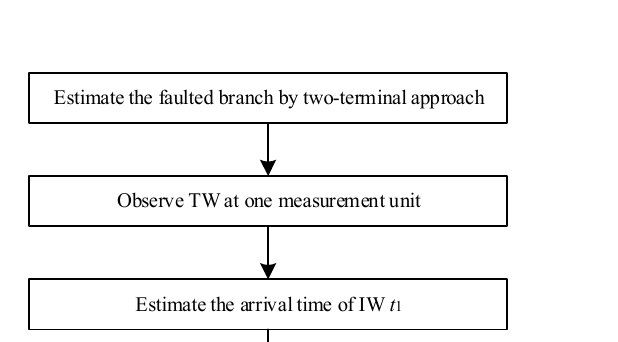
Figure 5. Wavelet-transform modulus-extremum (WTME) of the aerial-mode TW. 3.3. Consideration of Reducing Measurement Units in a Complex Network This section generalizes the two-step fault location approach in a complex network. As shown in Figure 6, a multi-level branch network is divided into two sub-networks to reduce the measurement units as much as possible. The basic idea is, in each sub-network, to select a backbone along which single-level branches are attached. In this way, a few synchronous measurement units can be easily applied in each sub-network. The result is shown in Figure 7, where the two sub- networks require four measurement units at points 1, 8, 14, and 18. It has to be noted that the sub- networks may have the same backbone sections such as the s ections 3–4 in Figure 7a,b. The principle to deploy measurement units is summarized as the following. (1) Put one measurement unit at the substation. (2) Search for one tee point in the direction outward from the substation. (3) Observe whether this tee point is connected to another tee point in the outward direction. If the result is positive, move on to the next tee point. (4) Observe whether this tee point is connected to the terminated branches. If the result is positive, put one measurement unit at any branch end. (5) Complete measurement unit deployment after all the tee points are considered. Time （ us ）